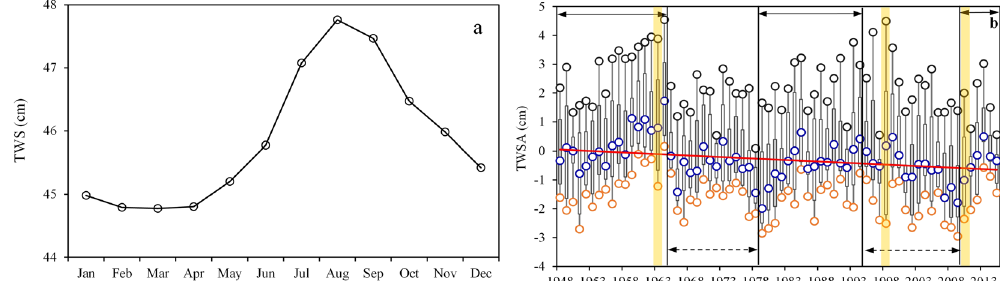
Figure 1. Inner-annual ( a ) and intra-annual ( b ) change trends of TWS from January 1948 to December 2015 (the grey symbol is the annual maximum value; the blue symbol is the annual median value; the orange symbol is the annual minimum value).